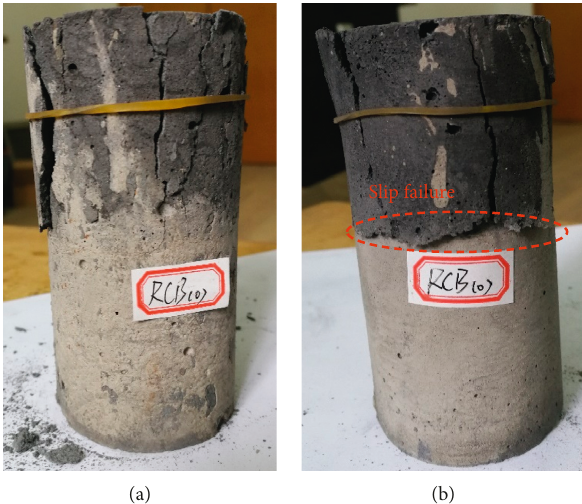
Figure 9: The failure law of the RCB(0) specimen under the constant loading rate.